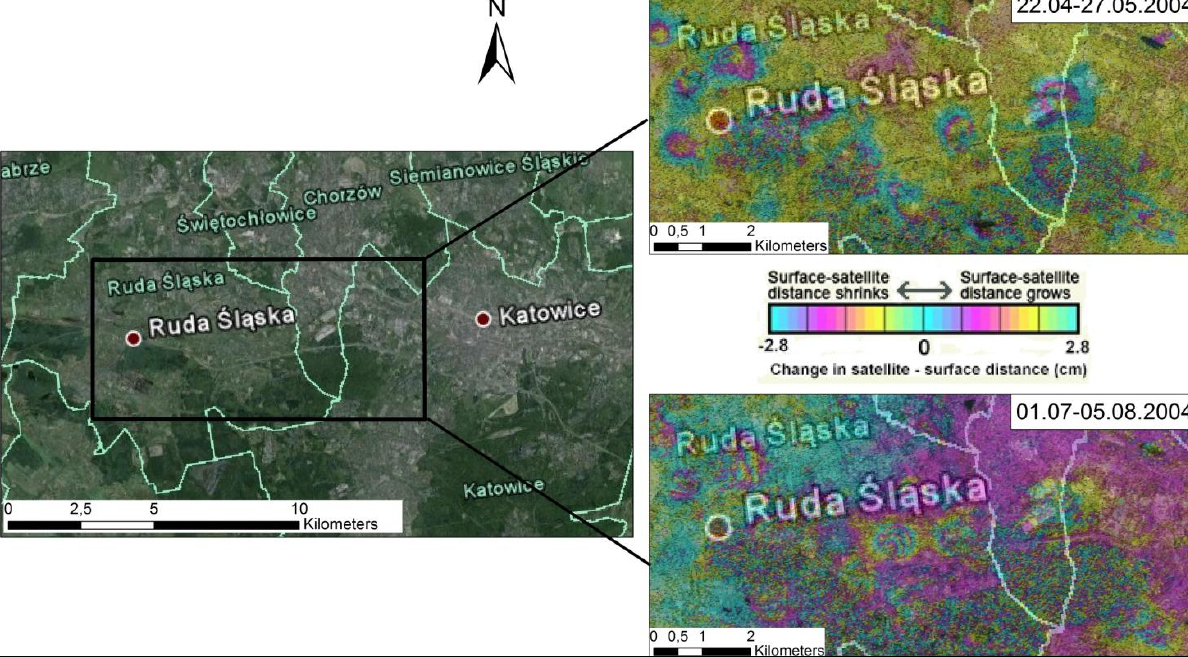
Fig. 3. Extended subsidence in a few months’ time range in Ruda Śląska, used images Envisat